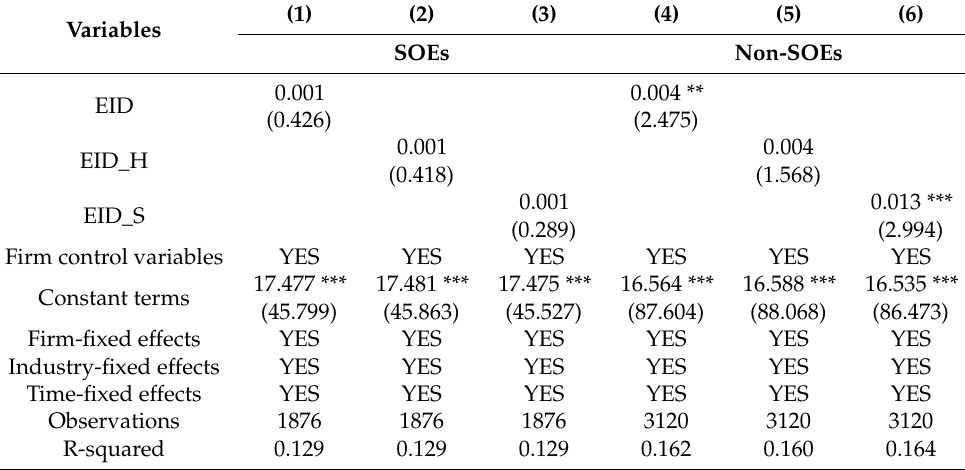
Table 5. Heterogeneity analysis: differences in the nature of enterprise property rights.